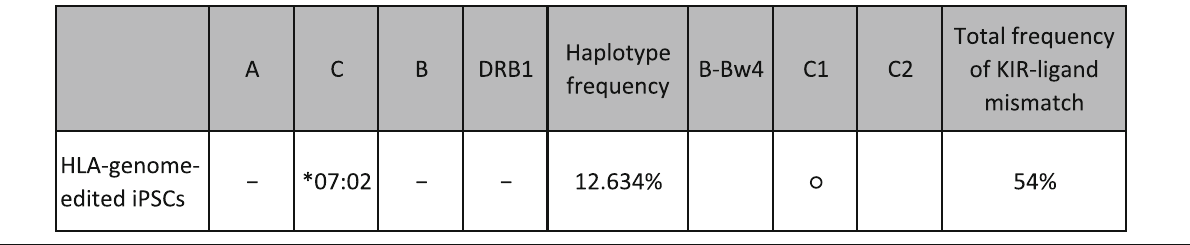
This genome-edited HLA-homo-iPSCs was produced using no. 3 shown in Table 1. Because HLA-A, B, and HLA-II was deleted. The frequency of a KIR-ligand mismatch regarding C1/C2 is 7.3% with the same logic used in Table 1 when the genome-edited HLA-homo-iPSCs carrying C1 epitope was used for the allogenic transplantation. In addition, the frequency of KIR-ligand mismatch regarding Bw4 is increased to 50% calculated as [1 − (1 − 0.3) × (1 − 0.3) = 0.51]. The total frequency of at least one mismatch is estimated to be about 54% calculated as [1 − (1 − 0.073) × (1 − 0.5) =